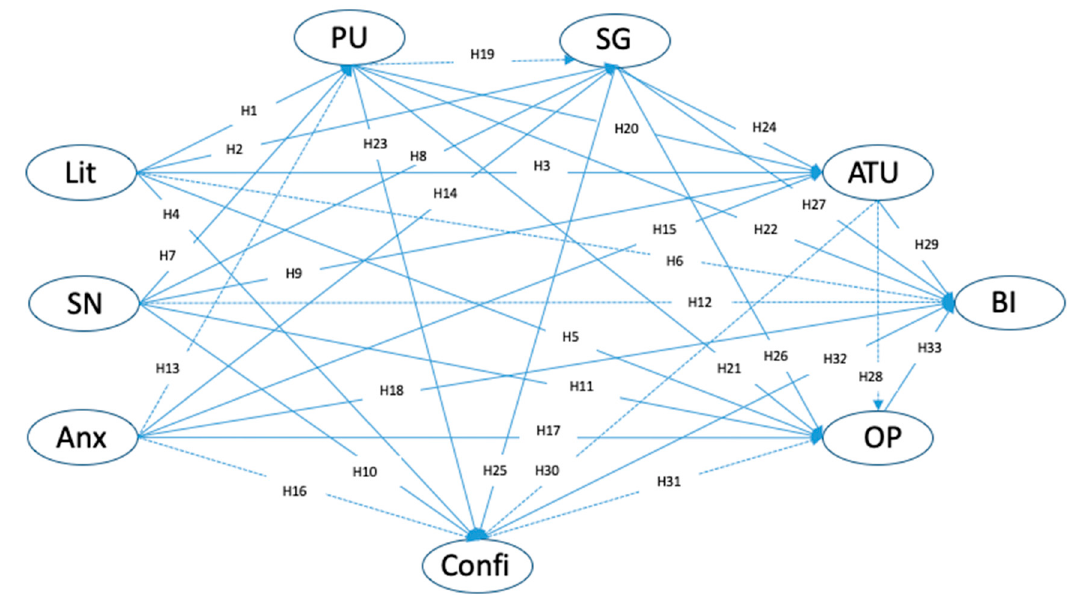
Figure 3. Results of the hypotheses testing. Lit: AI literacy; SN: subjective norms; Anx: AI anxiety; PU: perceived usefulness; SG: AI for social good; ATU: attitude towards using AI; Confi: confidence in learning AI; OP: AI optimism; BI: behavioral